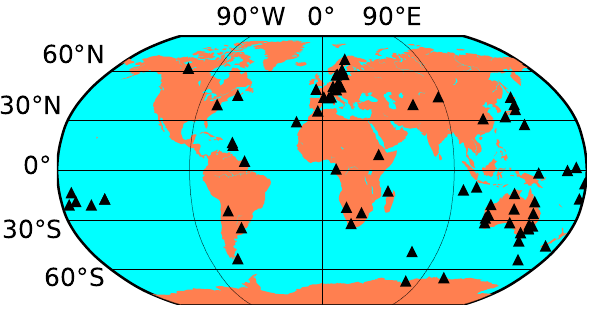
Figure 6. Globally distributed stations for global ionospheric modeling.